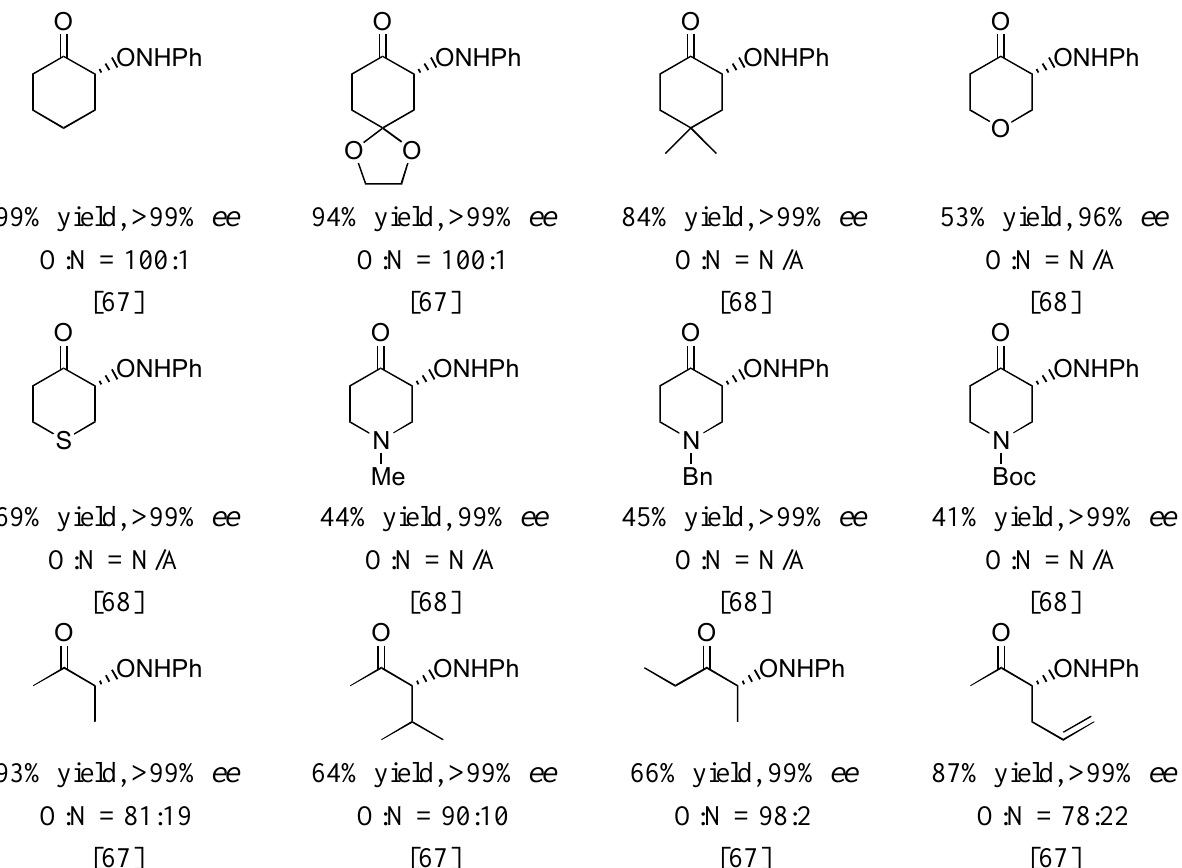
Figure 16. Examples of aminoxylated ketones obtained from L -proline ( 1 ) catalysis